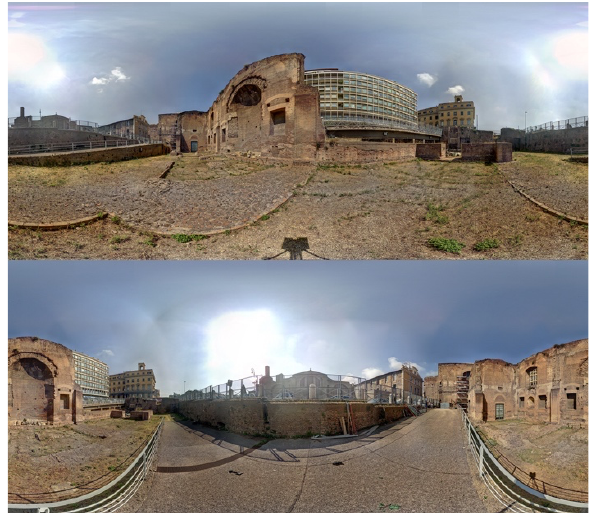
Figure 07 . Panoramic HDRI image, made during the survey campaign by laser